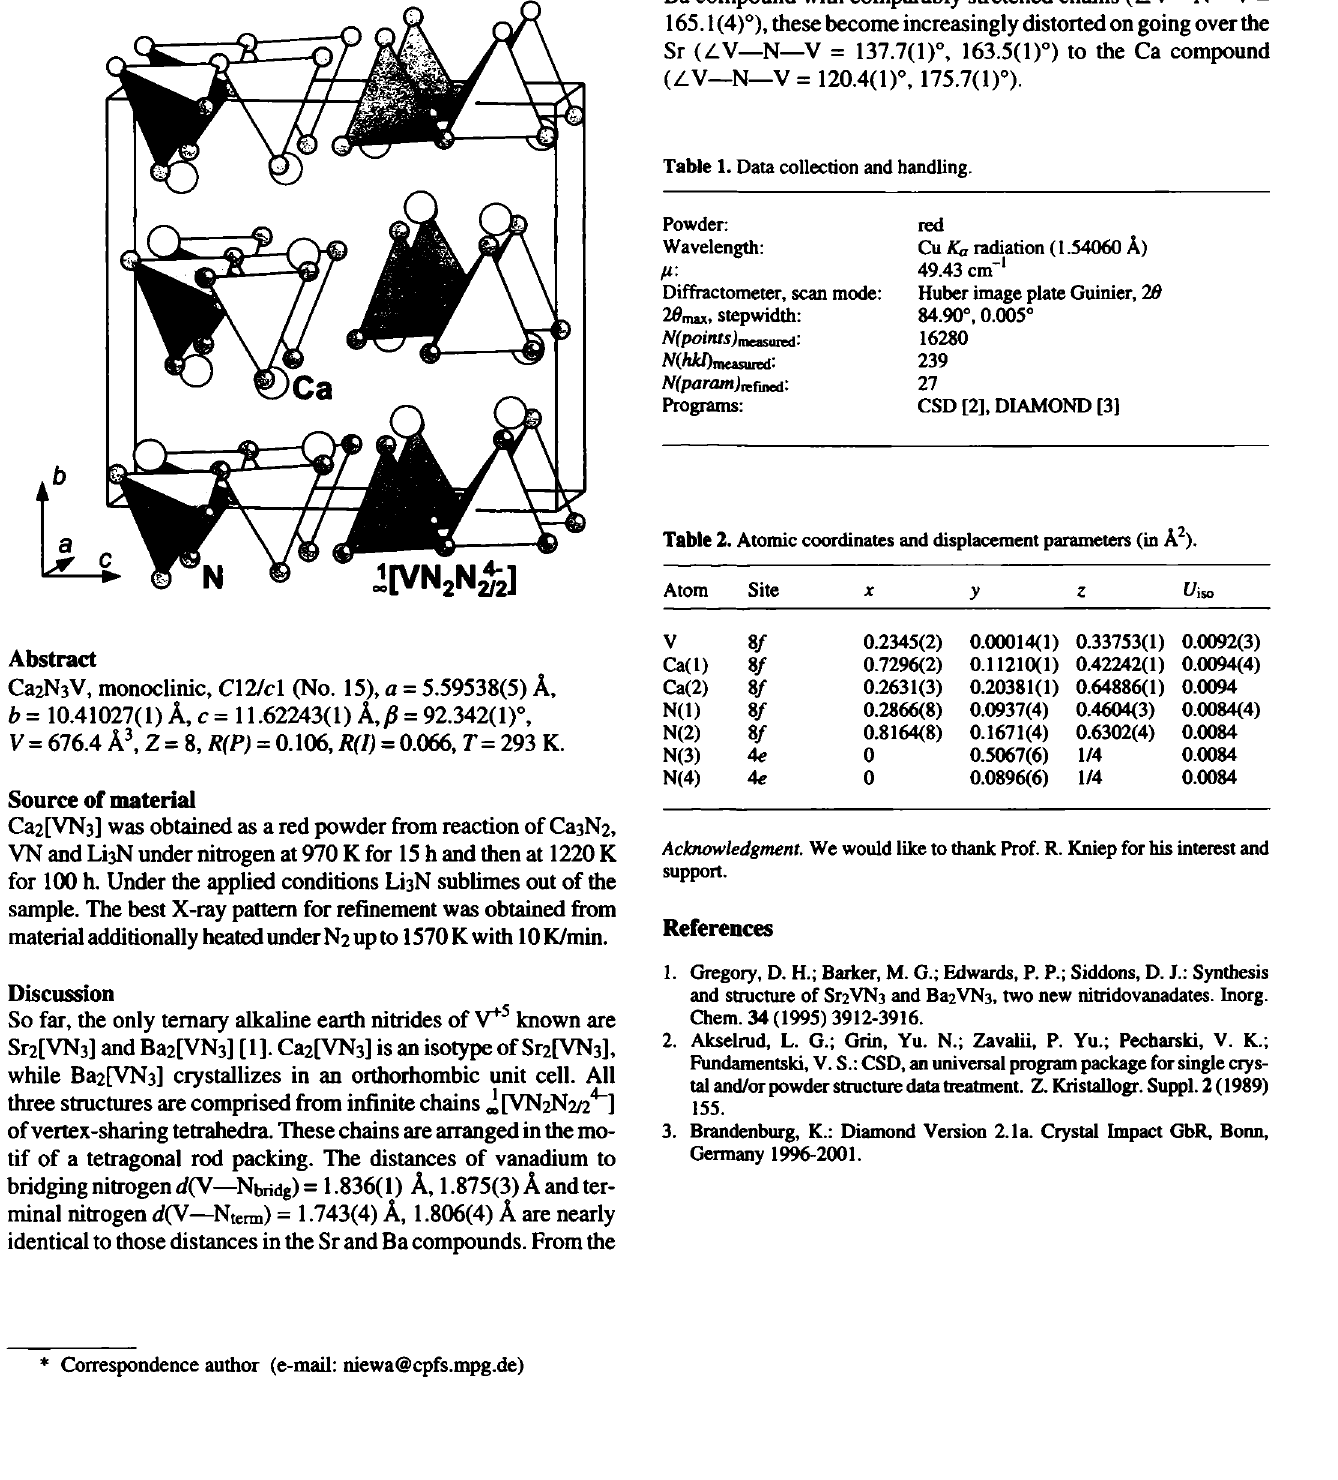
Ba compound with comparably stretched chains (Z.V—Ν—V = 165.1 (4)°), these become increasingly distorted on going over the